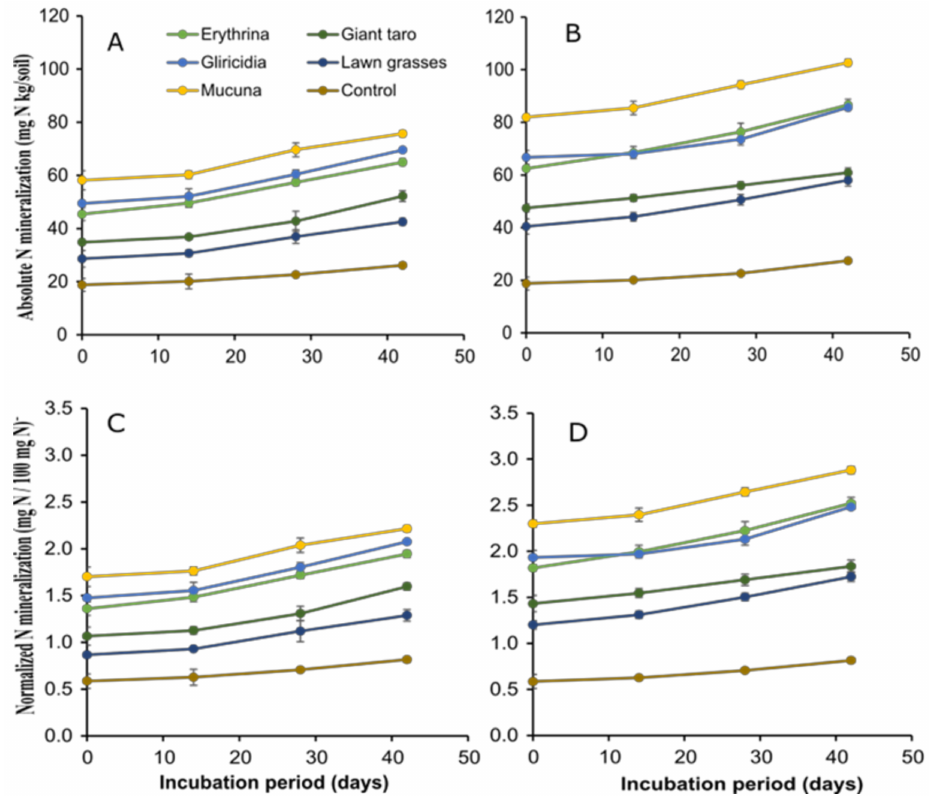
Figure 1. Absolute (mg kg − 1 soil) ( A , B ) and relative (mg N 100 mg − 1 N) N mineralization ( C , D ) from organic amended @ 10 ( A , C ) and 20 t ha − 1 ( B , D ) during 42 days of incubation study (mean ± standard